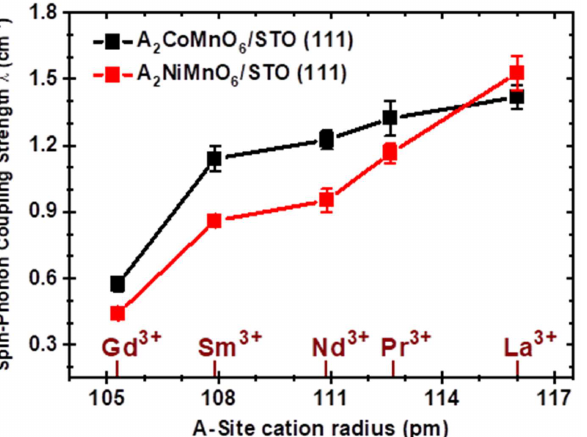
Figure 6. The spin-phonon coupling strength, λ , of the B-site-ordered A 2 CoMnO 6 and A 2 NiMNO 6 thin film series on STO(111) as a function of the A-site cation radius. The values were extracted from the phonon renormalization of the A g breathing mode in the ferromagnetic phase below T C .